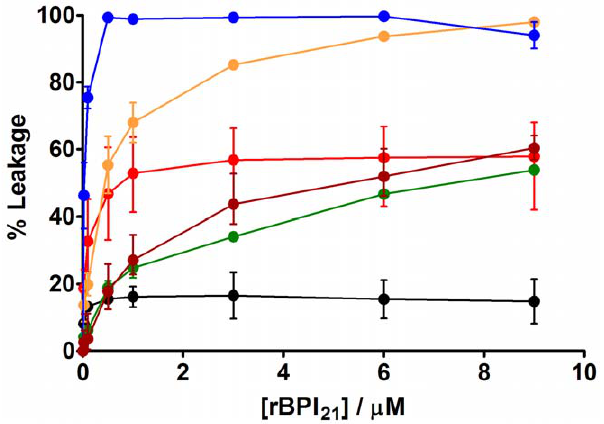
Figure 7. rBPI 21 -induced membrane leakage. Carboxyfluorescein fluorescence increase measured 20 min after rBPI 21 addition in POPC (black circles), POPC:LPS 80:20 (red circles), POPC:POPG 80:20 (green circles), POPC:POPG 55:45 (orange circles), POPC:POPG:LPS 60:20:20 (brown circles) and POPG (blue circles) liposomes. Bars represent the range from at least two independent experiments. The differences in leakage percentages for rBPI 21 9 m M were statistically significant for the following data pairs: POPC/POPC:LPS (80:20), POPC/POPC:POPG (80:20), POPC/POPC:POPG (55:45), POPC/POPG, POPC/POPC:POPG:LPS (60:20:20), POPC:LPS (80:20)/POPG:POPG (55:45), POPC:LPS (80:20)/ POPG, POPC:POPG (80:20)/POPC:POPG (55:45), POPC:POPG (80:20)/ POPG, POPC:POPG (55:45)/POPC:POPG:LPS (60:20:20) and POPC: POPG:LPS (60:20:20)/POPG.